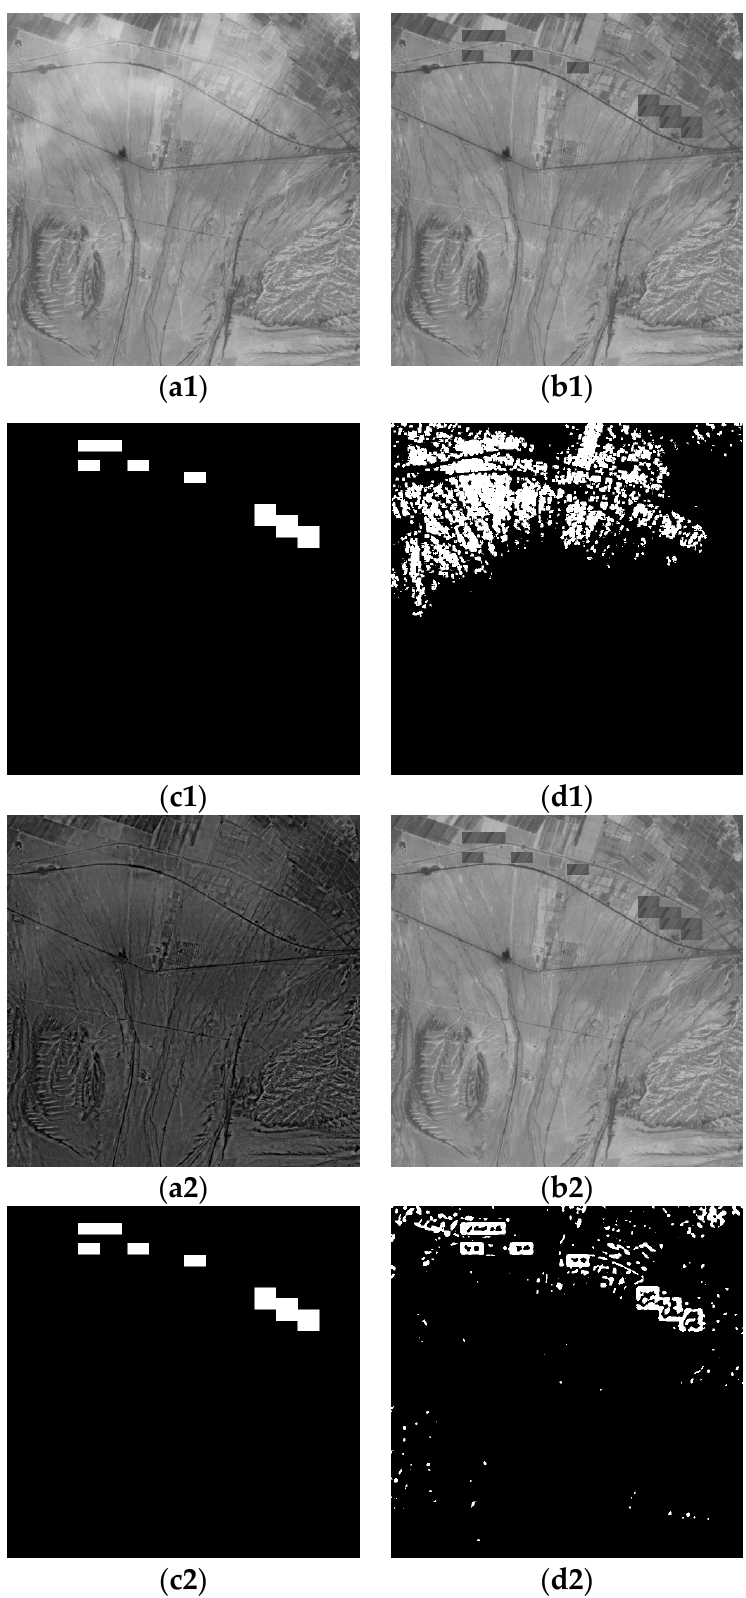
Figure 6. Comparison of changes before and after thin cloud removal: ( a1 ) before removing thin clouds (phase one); ( a2 ) after removing thin clouds (phase one); ( b1 , b2 ) phase two; ( c1 , c2 ) reference; ( d1 ) the results before removing thin clouds; ( d2 ) the results after removing thin clouds.